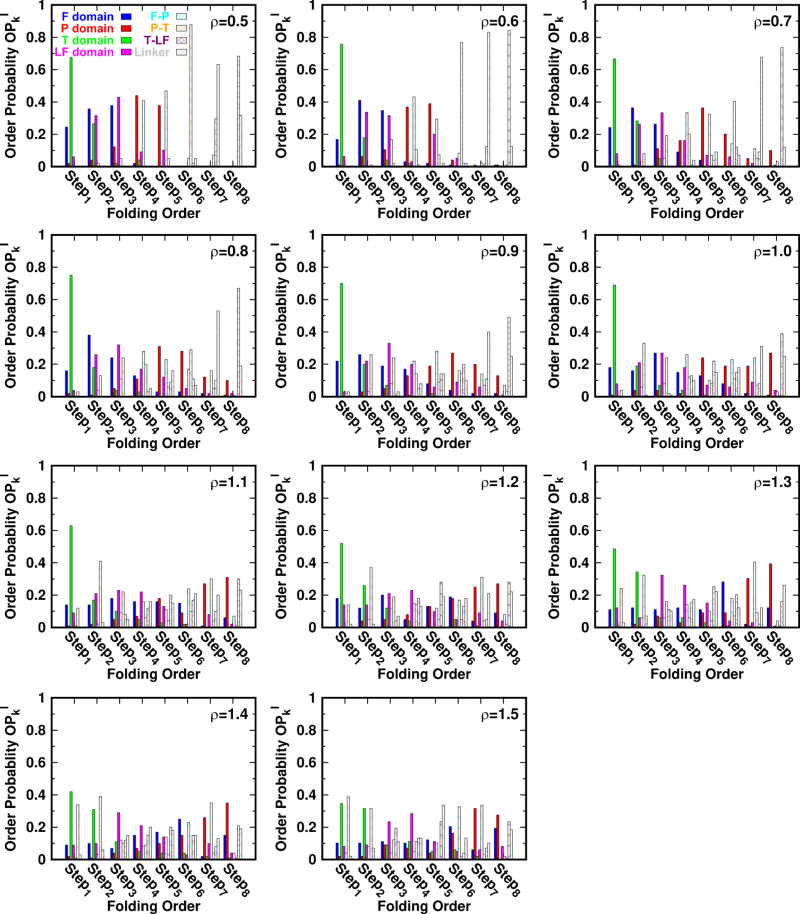
OPkI for different values of ρ.Folding order probability OPkI of intra- and interdomains for different values of ρ.